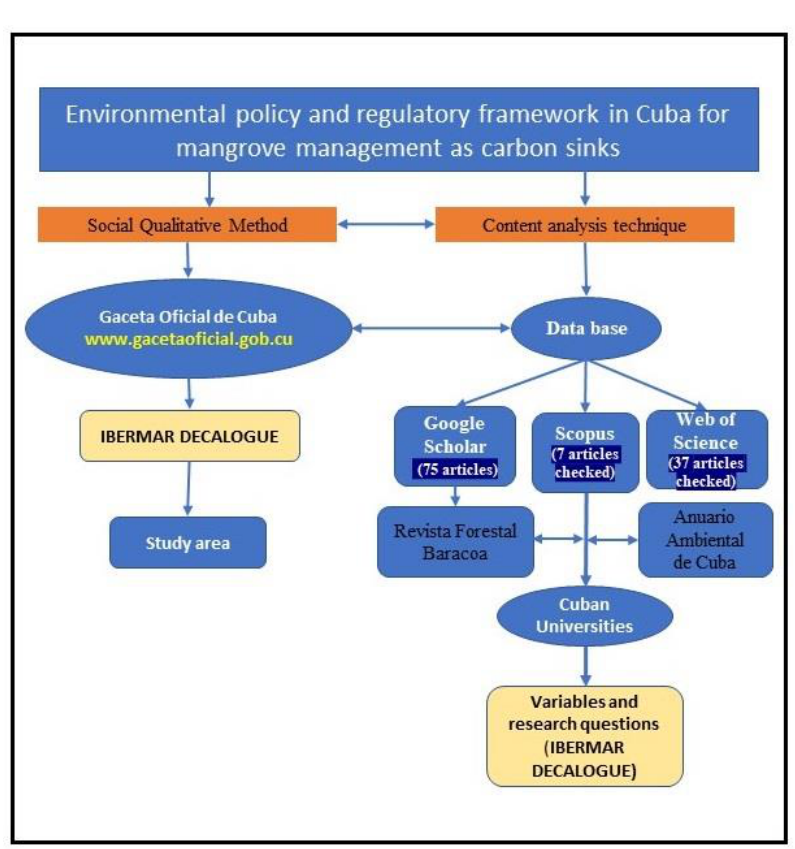
Figure 1. Research methodological framework. (www.gacetaoficial.gob.cu, accessed on 6 February 2022).